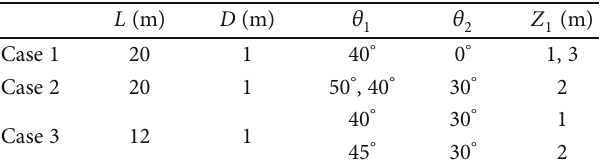
Figure 9: De fl ection curve of pile head for comparison. Table 1: Summary of three-dimensional numerical analysis conditions.